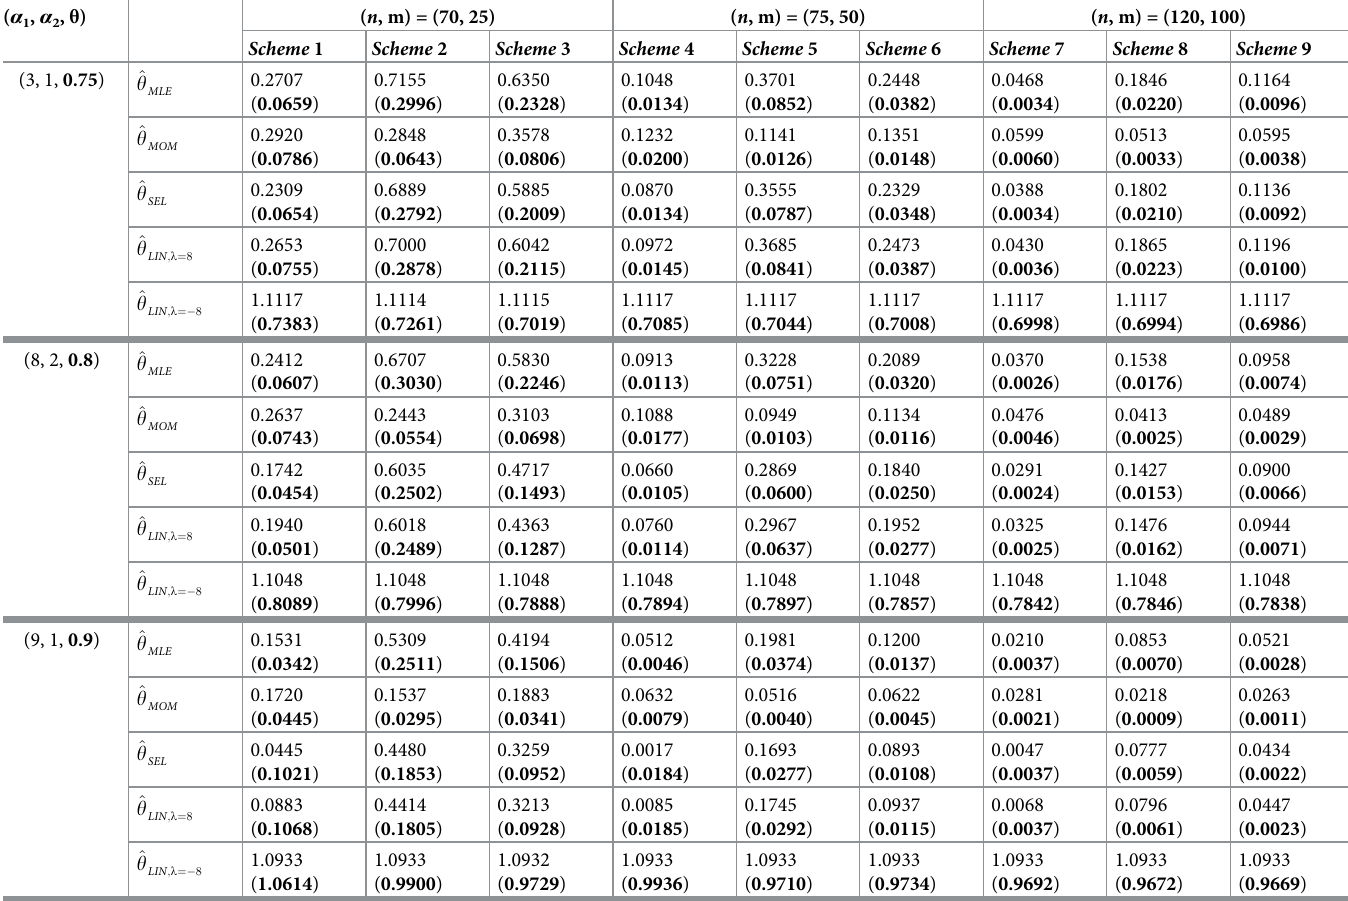
Table 3. Absolute relative bias( ARBias ) and MSE (in parentheses) of ^ θ with theoretical value of θ >